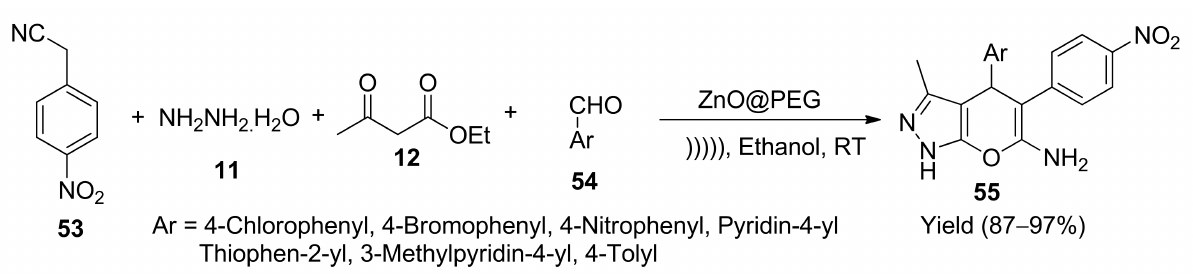
Scheme 14. Synthesis of pyranopyrazole derivatives 55 using